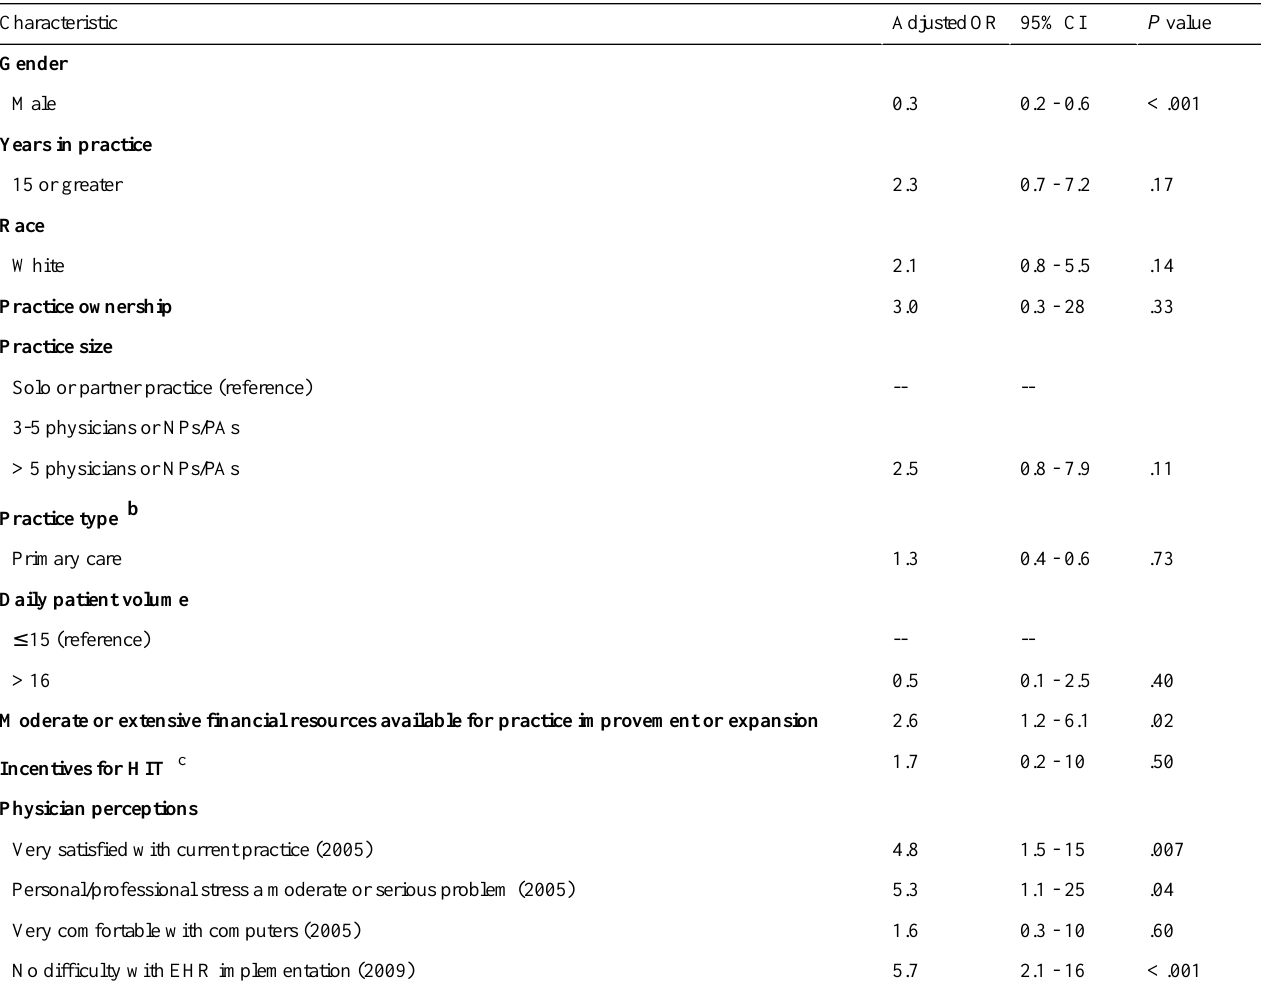
Table 2. Multivariate relationship between practice characteristics and physician perceptions of practices and physician satisfaction (n = 119).